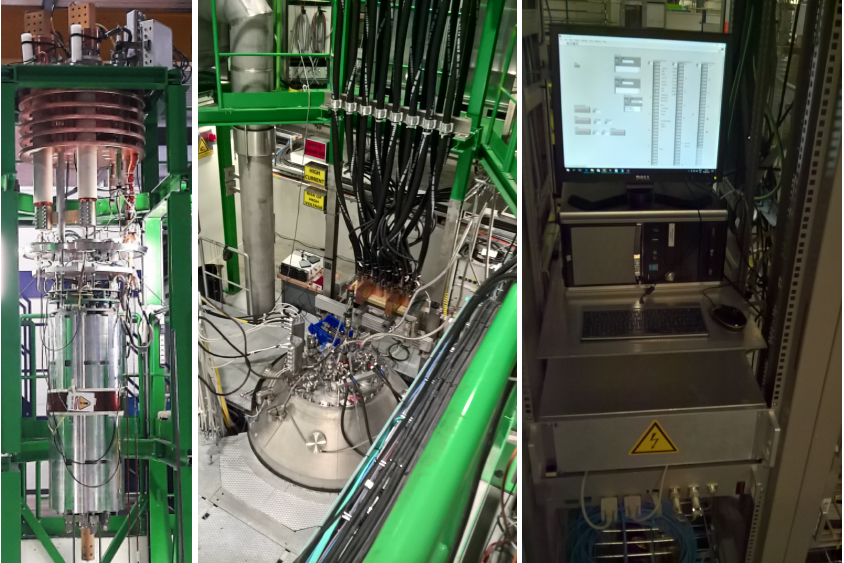
Figure 3. Test facilities of SM18 for testing MQXFS inner triplet quadrupole magnet, including the rack used for the data acquisition and tests (photos provided by